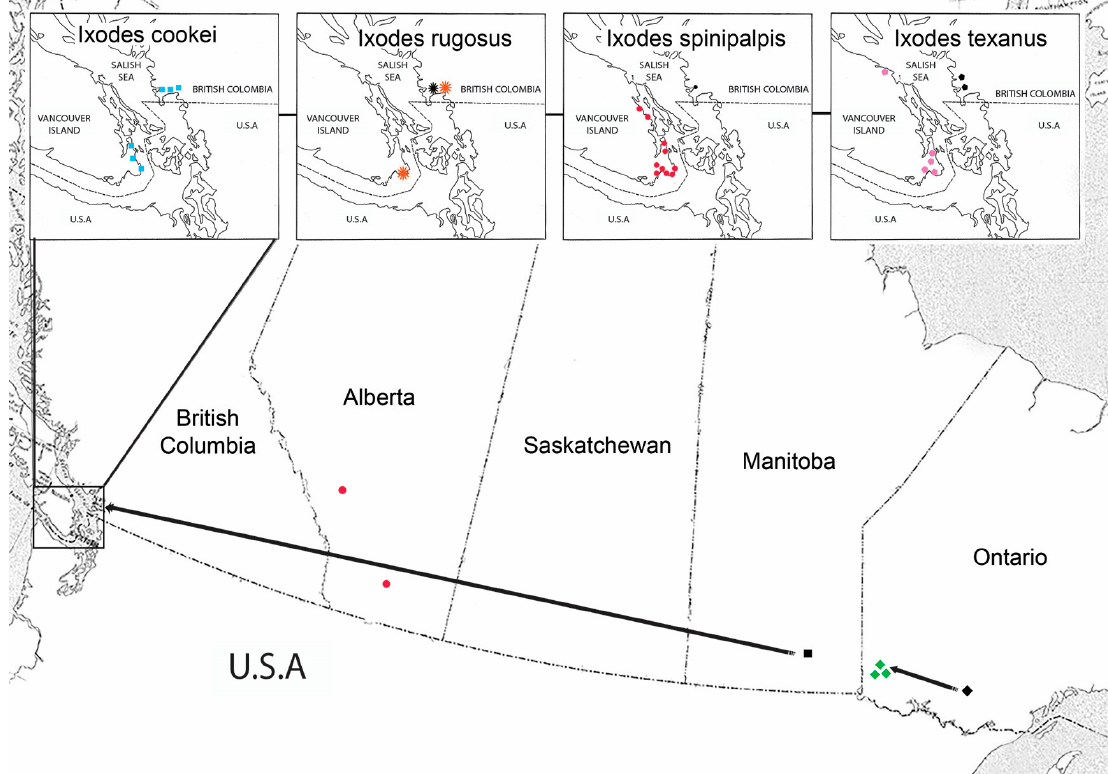
Figure 1. Map of western Canada showing baseline and current biographical distribution of five Ixodes spp. Black symbols represent benchmark sightings for the tick species [7,8]. Color symbols represent current sighting for I. cookei (blue square), I. gregsoni (green diamond), I. rugosus (orange star), I. spinipalpis (red dot), and I. texanus (mauve polygon).